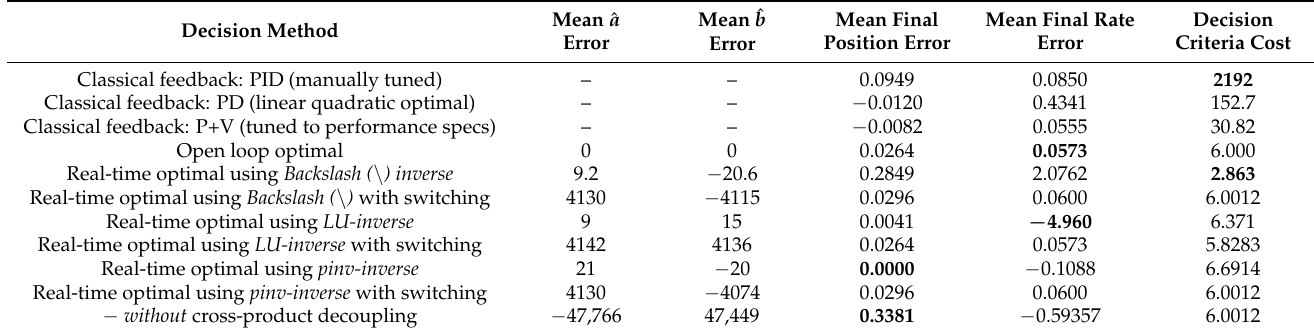
Table 10. Comparison of real-time optimal decision